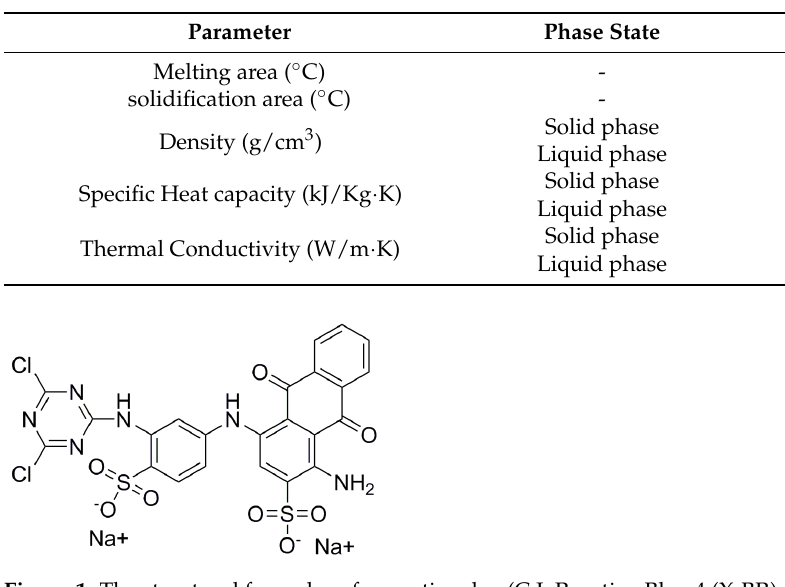
Figure 1. The structural formulas of a reactive dye (C.I. Reactive Blue 4 (X-BR). Table 2. Detailed preparation parameters for paraffin@SiO 2 colored microcapsules.